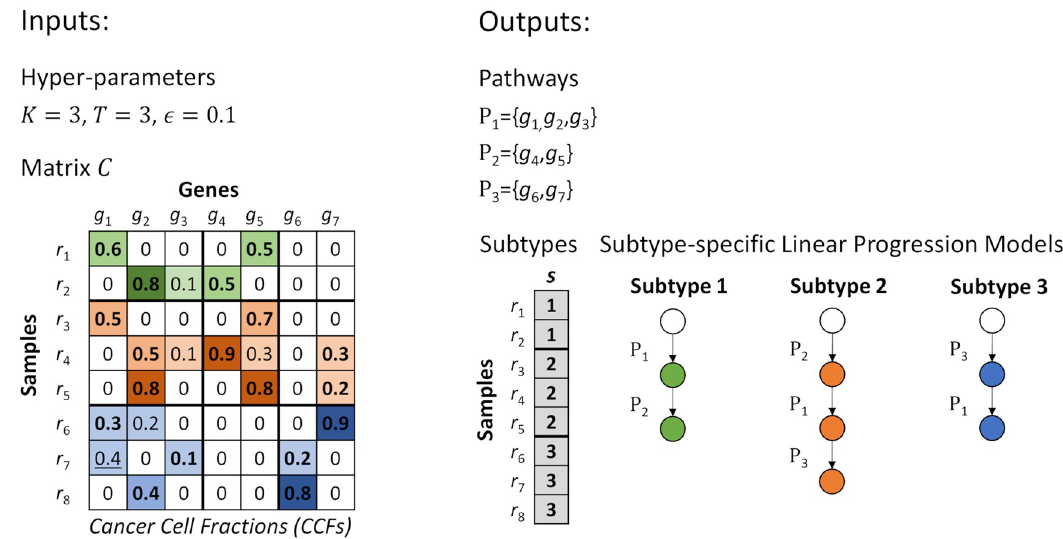
Fig 1. An example input with the corresponding